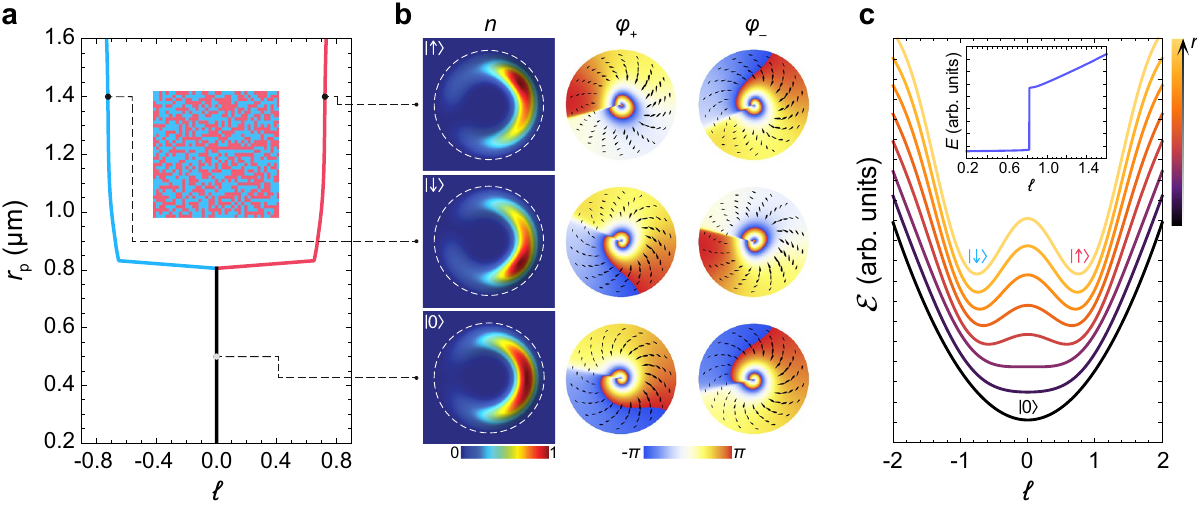
Figure 2. Spontaneous symmetry breaking of the polariton current state under SOI. ( a ) Variation of the average OAM per particle, ℓ , of the exciton-polariton condensate with the displacement of the pump spot from the center of the pillar, r p , under the linearly-polarized non-resonant optical pump ( p = 0 ). The insert shows results of a series of numerical experiments at r p = 1.4 µ m . Each pixel corresponds to a separate numerical experiment. Pink and blue colors correspond to the states | ↑� and | ↓� , respectively. ( b ) Spatial distribution of the density of the polariton condensate, n (left), as well as of the phase of the left-circularly, 𝜑 + (middle), and right-circularly, 𝜑 − (right) polarized components of the condensate for the polariton states | ↑� , | ↓� and | 0 � indicated in ( a ). The black drops in the middle and right columns show the polariton currents in the corresponding polarizations. ( c ) The change of the dependence of the energy functional, E ( 𝓁 ) , on OAM with the displacement of the pump spot. The insert in ( c ) shows the change of the energy, E , of the ground states of the polariton condensate corresponding to the minima of the functional E ( 𝓁 ) with increasing r p